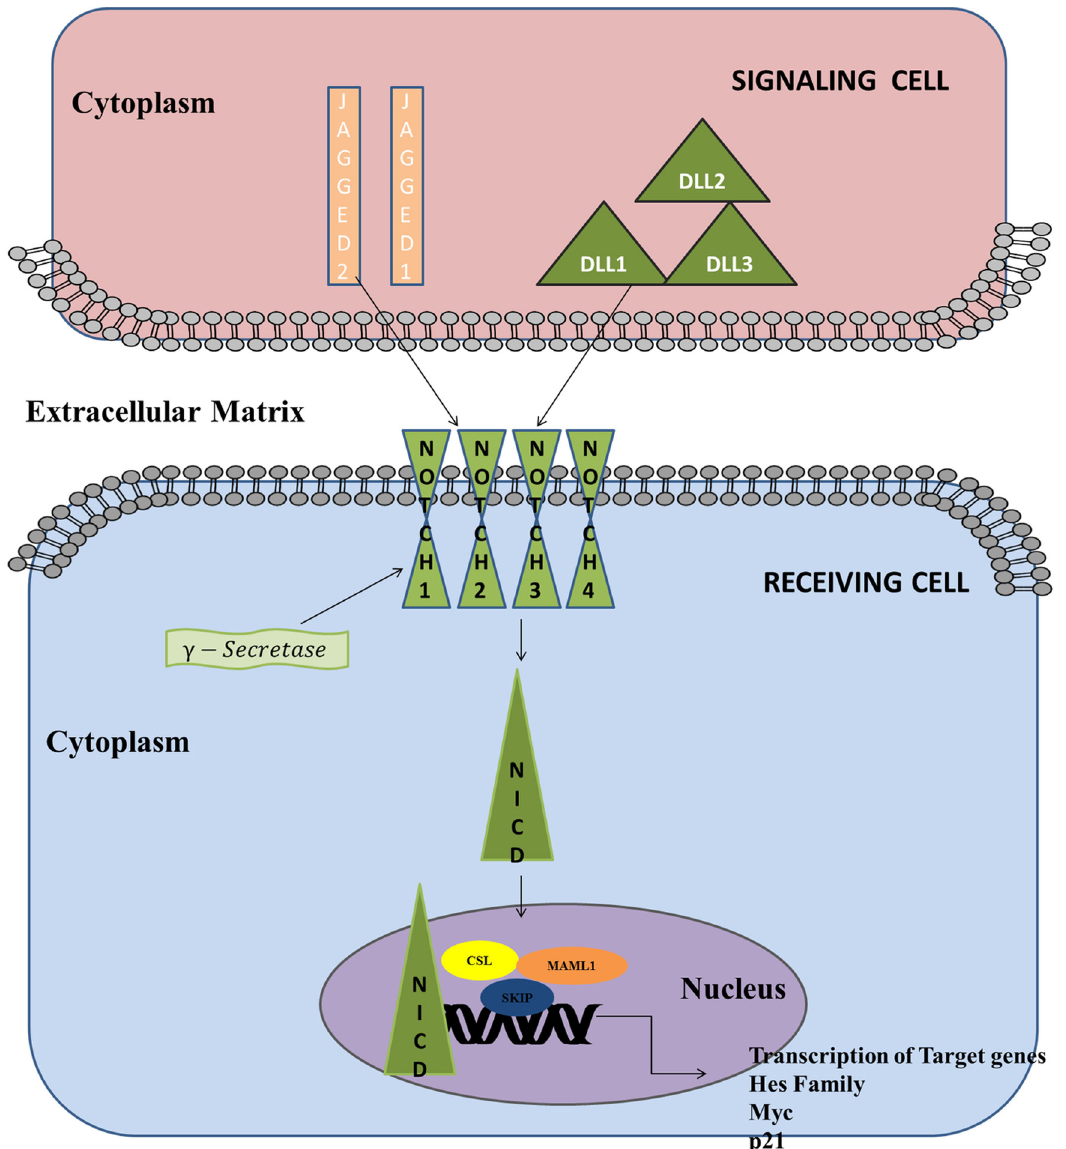
FIGURE 3 - Notch Signaling Pathway: It is active between two cells in close proximity, one acts as a signal transducer and the other as the signal receiver. The signalling cell releases the ligands; Jagged1, Jagged2, Delta-like-1 (Dll-1), Delta-like-3 (Dll- 3) and Delta-like-4 (Dll-4), which binds to the receptors; Notch-1, -2, -3 and -4 present on the receiving cell. This activates γ-secretase which in turn cleaves Notch intracellular domain (NICD) of the receptor. NICD translocates to the nucleus and binds with CSL protein, Ski-interacting protein (SKIP) and mastermind-like proteins (MAML) and ultimately affect the expression of target